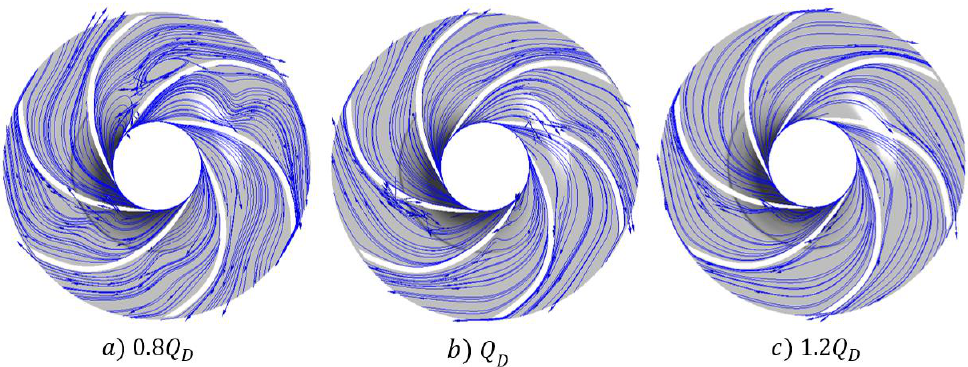
Figure 13. Velocity streamlines on the surface at a 20% constant span between the impeller hub and shroud at various flow rates: ( a ) 80% rated flow , Q D , ( b ) rated flow , Q D , ( c ) 120% rated flow , Q D